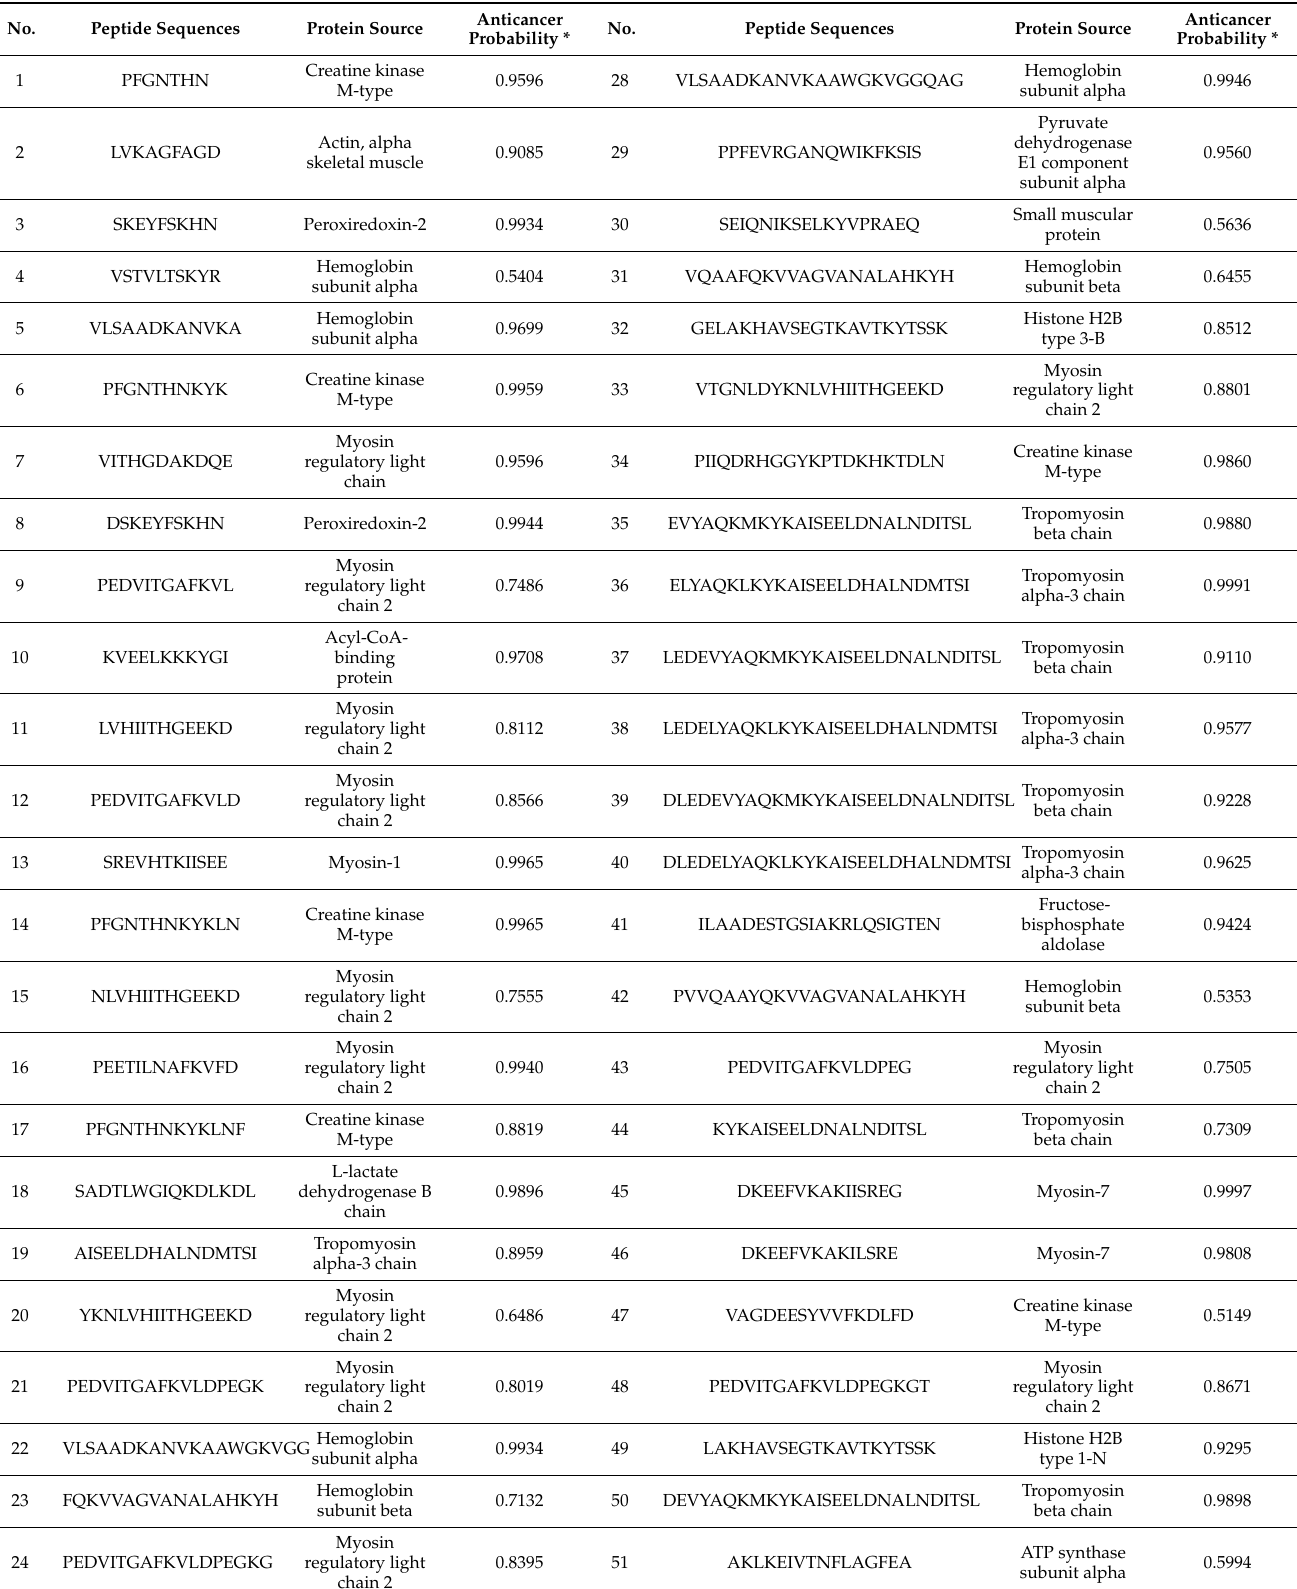
Table 1. List of potentially anticancer peptide sequences found in all the analyzed